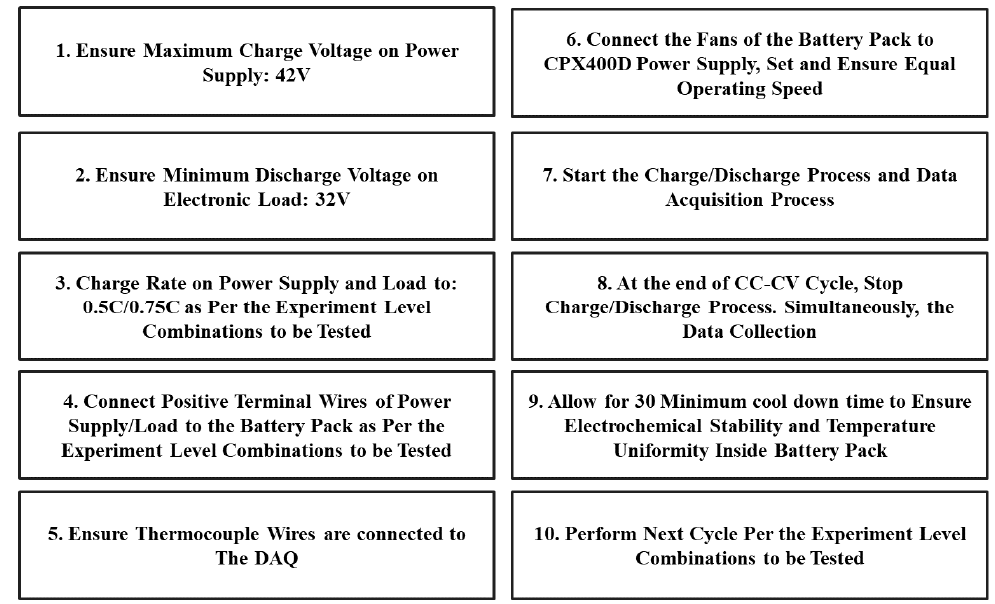
Figure 13. Experiment cycle procedures. CC-CV: constant current–constant voltage.